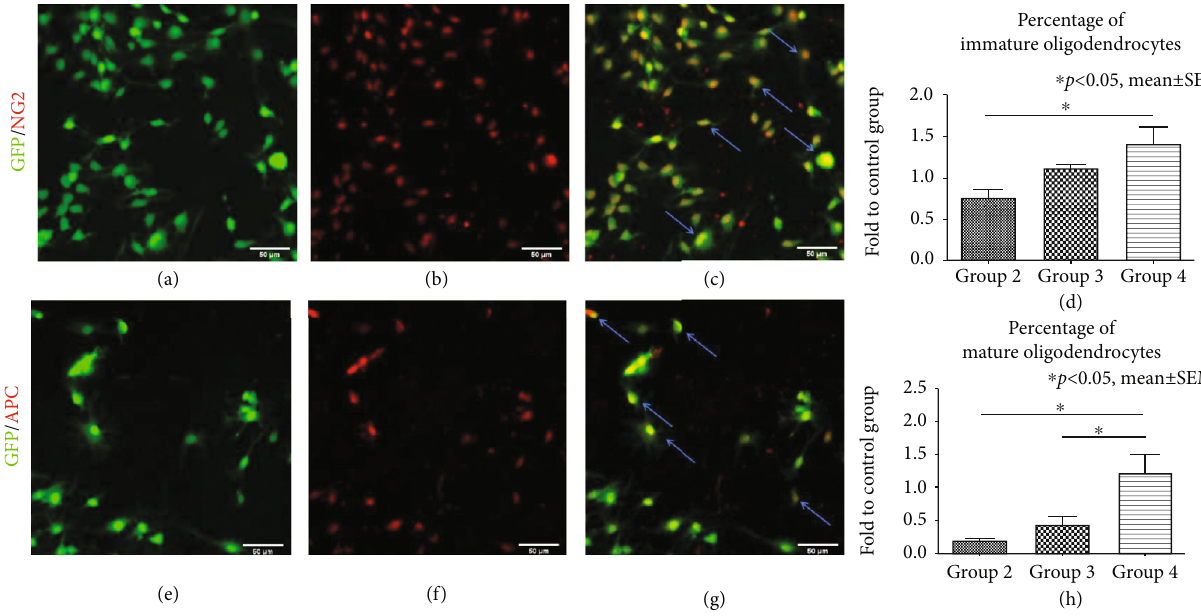
Figure 3: Di ff erentiation of NPCs towards the oligodendroglial lineage in vitro . (a-c) Costaining of GFP + /NG2 + cells (blue arrows) indicating oligodendrocyte precursors. (d) Quanti fi cation of oligodendrocyte precursors after 7 days of incubation with the di ff erent growth factor concentrations/combinations in groups 2-4, expressed in proportion to (fold to) the control group (group 1). (e-g) Costaining of GFP + /APC + cells (blue arrows) indicating mature oligodendrocytes. (h) Quanti fi cation of mature oligodendrocytes after 7 days of incubation with the di ff erent growth factor concentrations/combinations in groups 2-4, expressed in proportion to (fold to) the control group (group 1).